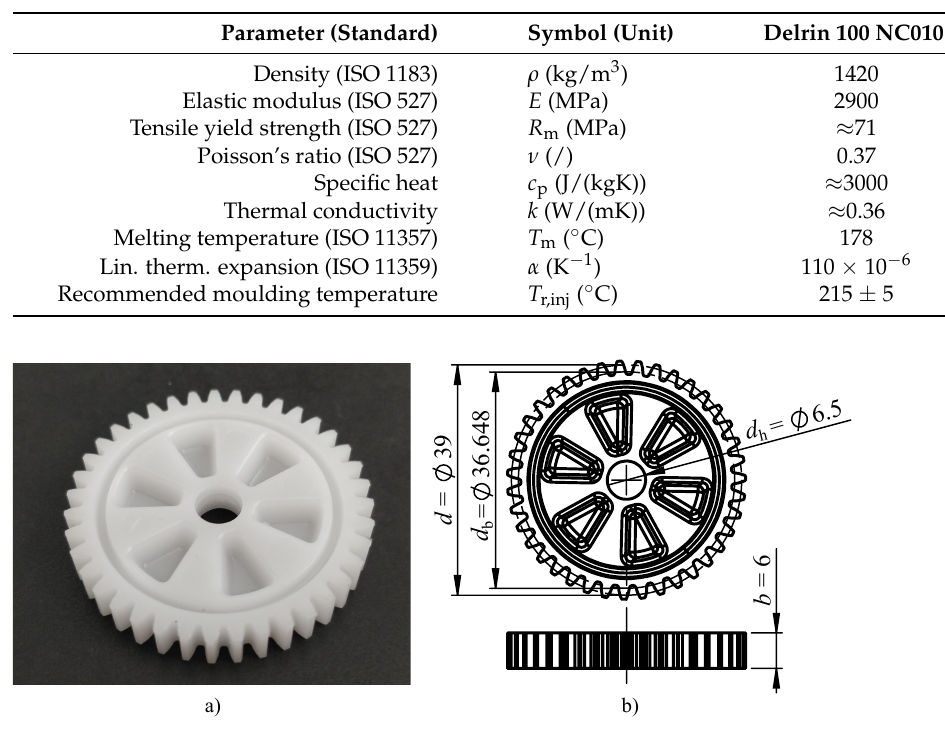
Figure 2. ( a ) Manufactured gear. ( b ) Gear dimensions.